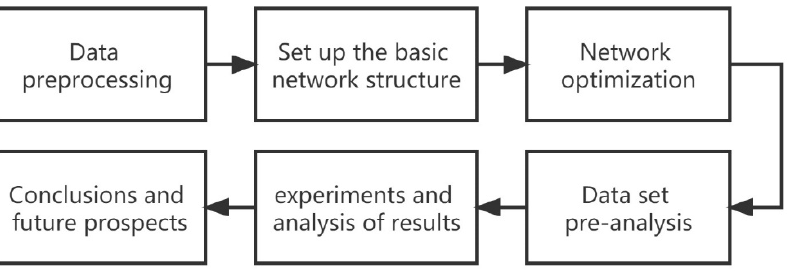
Figure 1. The overall working structure is in this